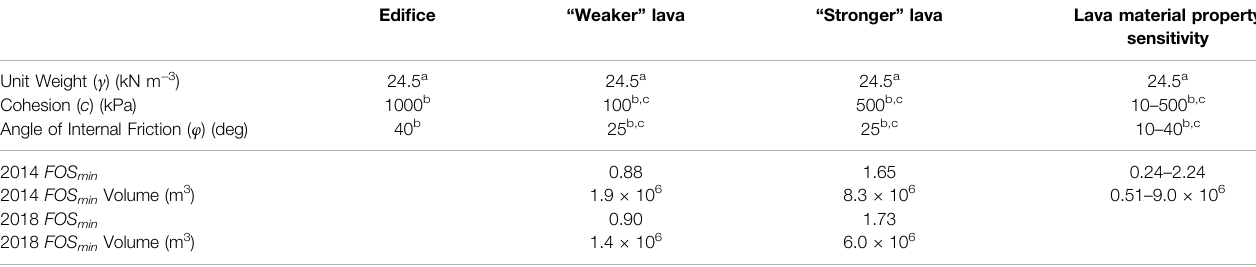
TABLE 1 | Model input parameters and results. Material properties for the edi fi ce (de fi ned as the pre-eruption topography from a 2010 DEM) were held constant for all Scoops3D runs. Properties for the erupted lava used values of cohesion and angle of internal friction representing “ stronger ” and “ weaker ” end members for both the 2014and2018DEMs.Lavaproperties werevariedovertheirlikelyrangestotestthesensitivityoftheresultingstabilityonthesepropertiesusingthe2014DEMasinput.The results shown are the FOS for the least stable potential failure ( FOS min ) and the volume of that potential